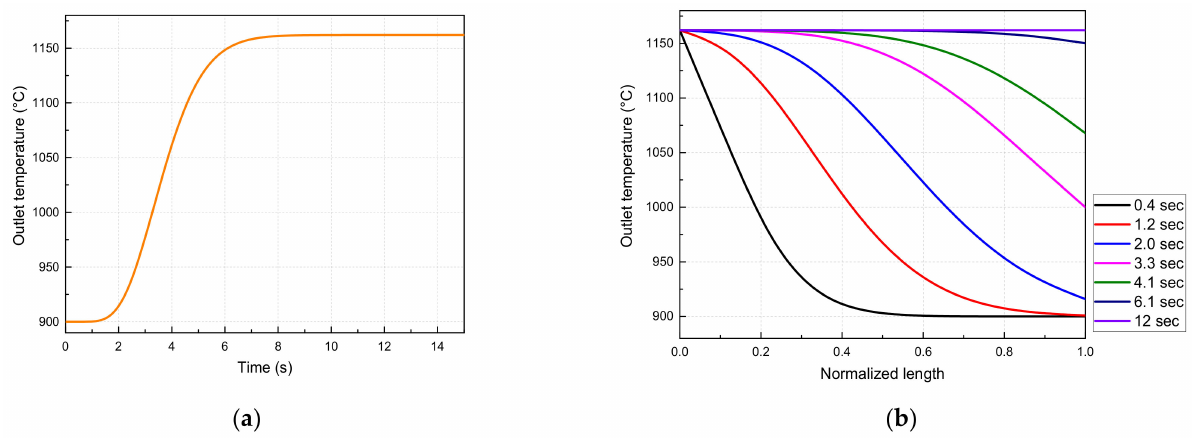
Figure 5. Dynamic response of the temperature: ( a ) temperature variation at the outlet of the combustion furnace; ( b ) temperature evolution across the combustion